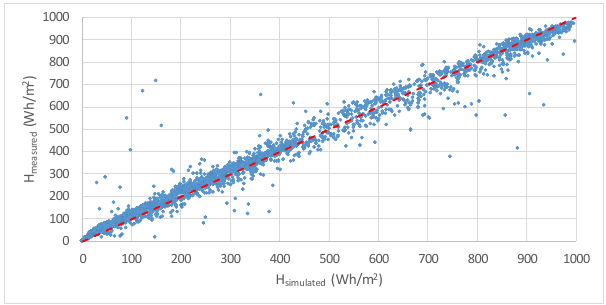
Figure 4. Plane-of-array irradiation model (red line is to guide your eyes).